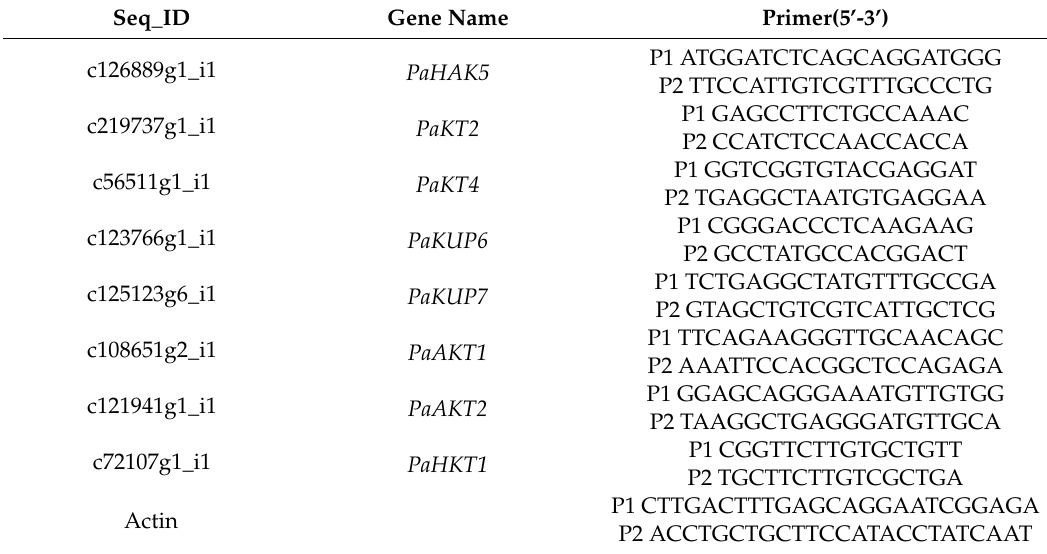
Table 3. Primers used in this